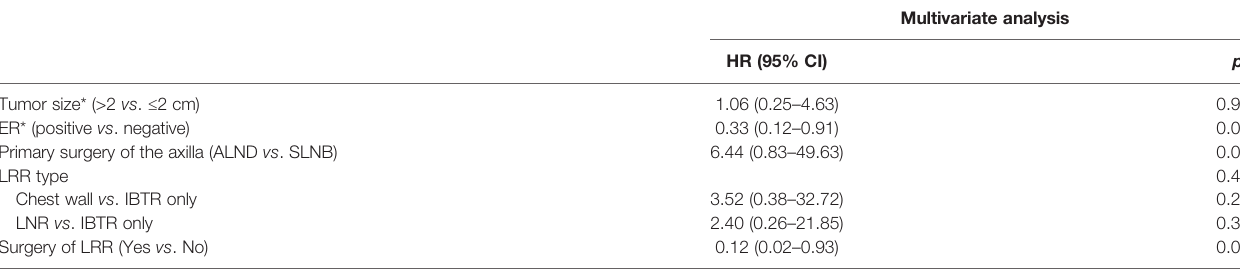
TABLE 5 | Multivariate analysis of factors associated with post-recurrence overall survival in patients with locoregional recurrence.